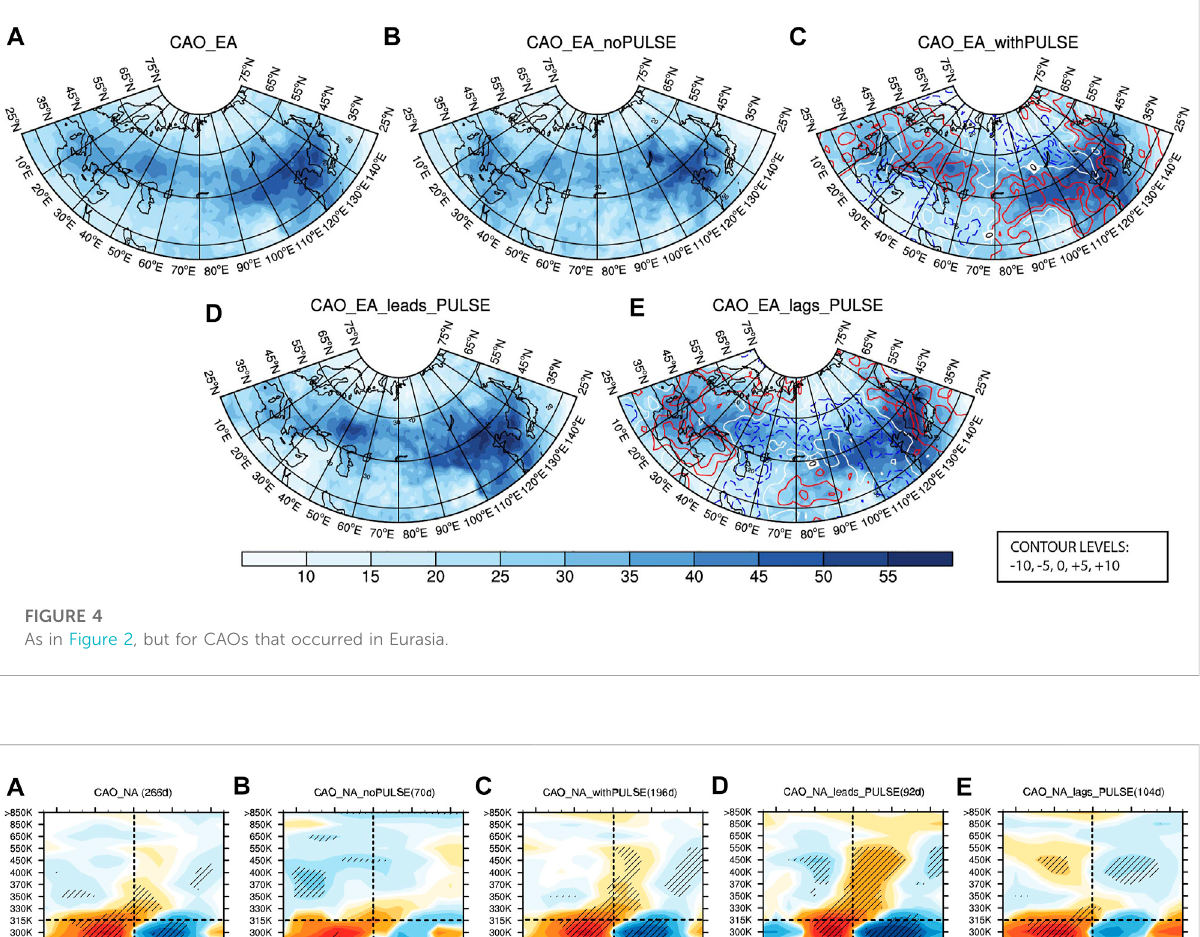
FIGURE 4 As in Figure 2, but for CAOs that occurred in Eurasia.